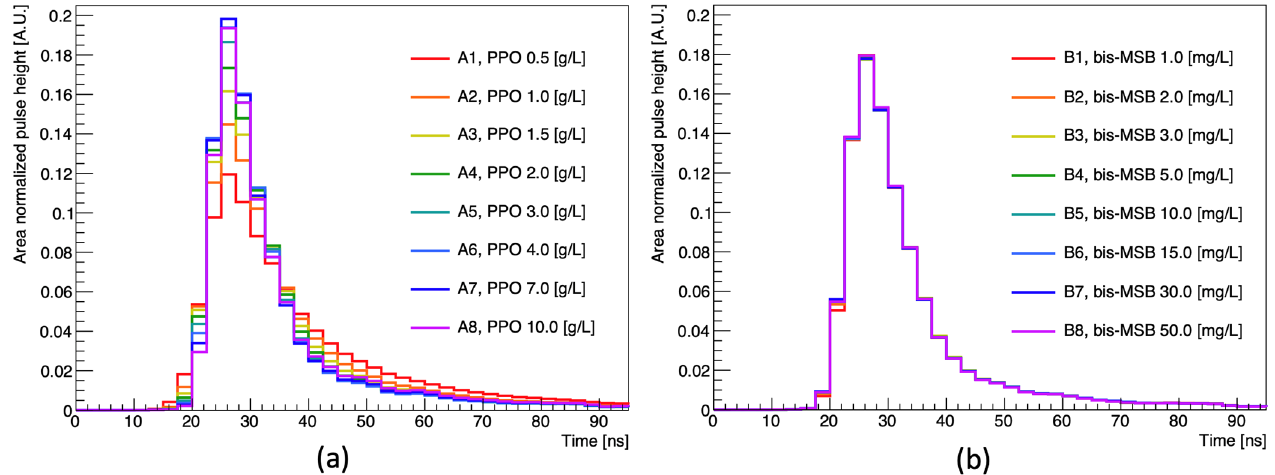
Figure 6. Area normalized waveform with different PPO and bis-MSB concentrations: ( a ) Pulse shape with varying PPO concentration; ( b ) Pulse shape with varying bis-MSB concentration. The PPO concentration is kept constant at 3 g/L. The waveform was obtained by averaging the area normalized pulse shape of 10,000 events.